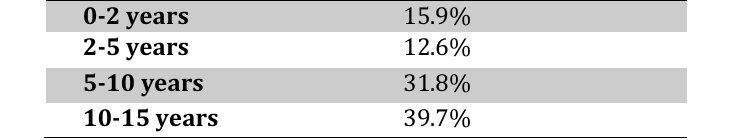
Table 1 . Working experience.